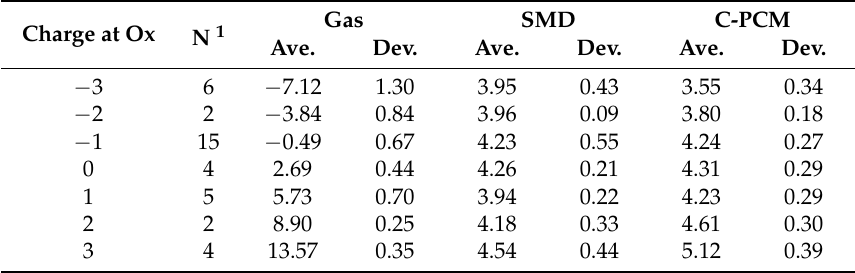
Table 1. The charge dependencies on the average and the deviation for the value E AIP − E exp (in eV). Charge at Ox N